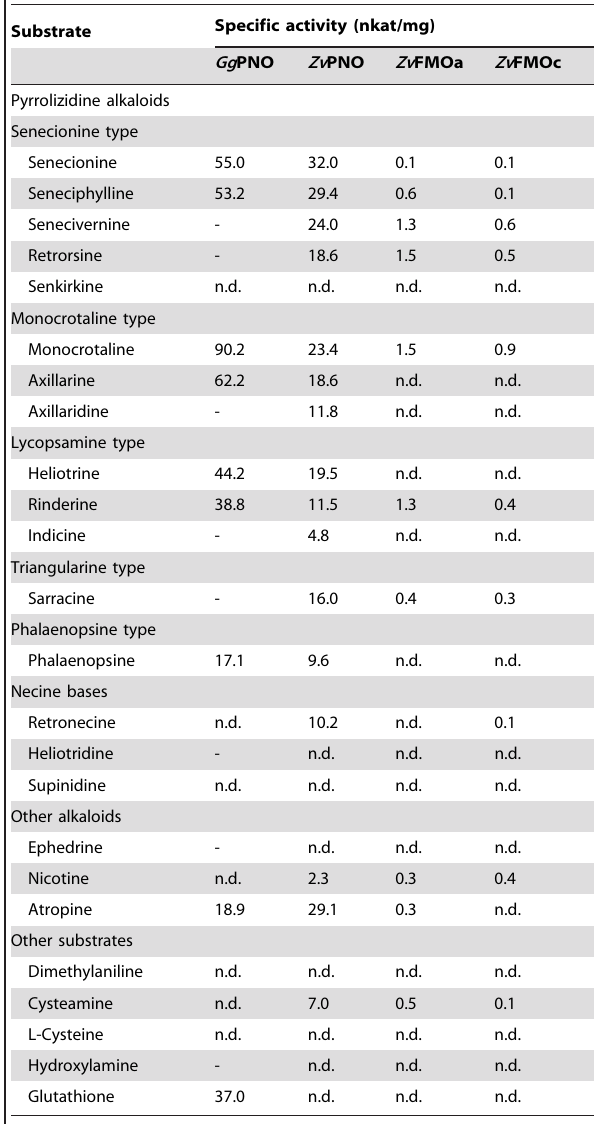
For comparison, the full coding regions were used. Tj SNO, Senecionine N -oxygenase of Tyria jacobaeae ; Dm FMO3006 and Dm FMO3174, FMO sequences of unknown function present in the genome of Drosophila melanogaster ; Hs FMO1, FMO1 of human. Table 2. Substrate specificity of recombinant flavin- dependent monooxygenases of Z. variegatus